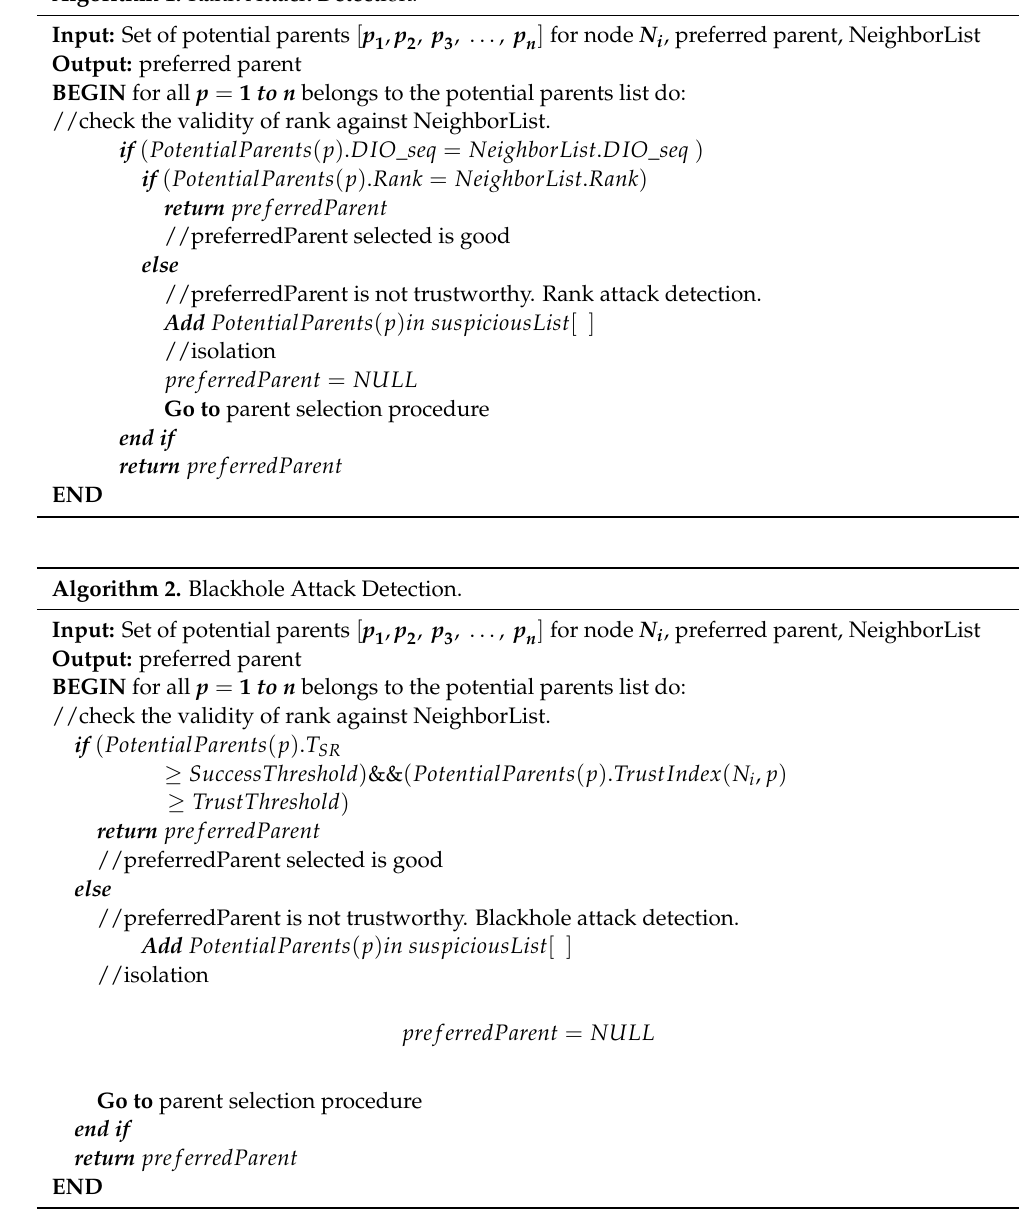
Algorithm 1. Rank Attack Detection.